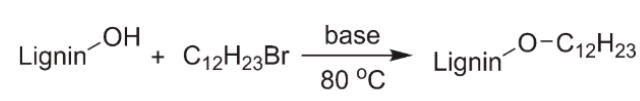
Figure 7. Reaction progress for the alkylation of lignin hydroxyl groups by bromododecane [88].